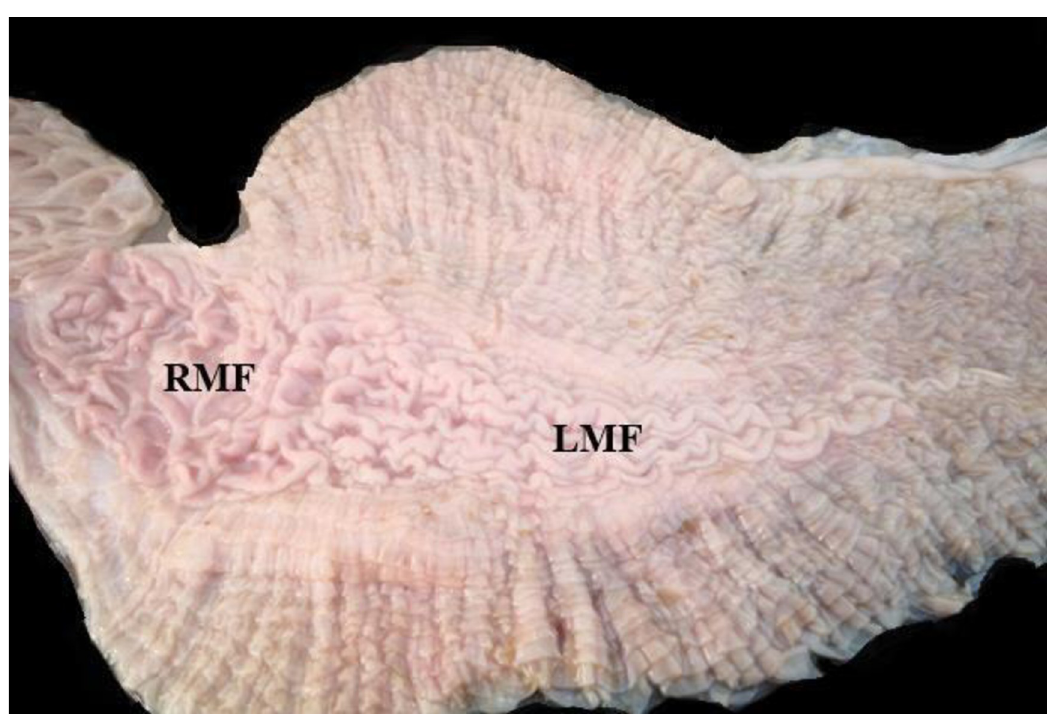
Fig 1. Sampling locations of the cardiac glandular area of abomasum in Dromedary stomach. RMF: reticular mucosal folds; LMF: longitudinal mucosal